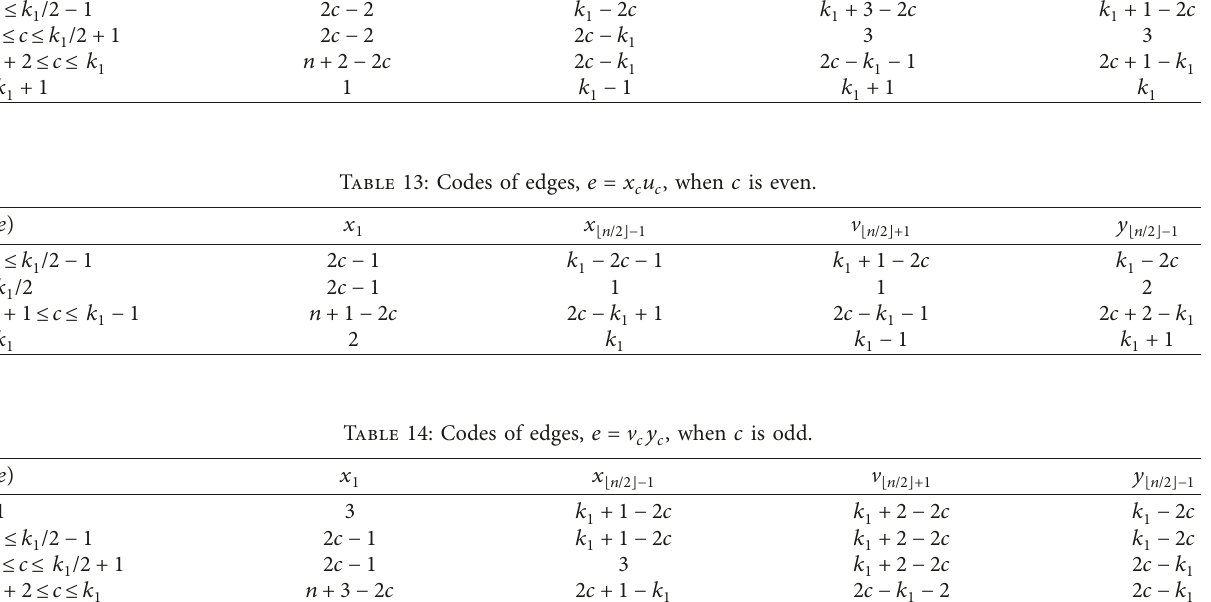
Table 12: Codes of edges, e � x